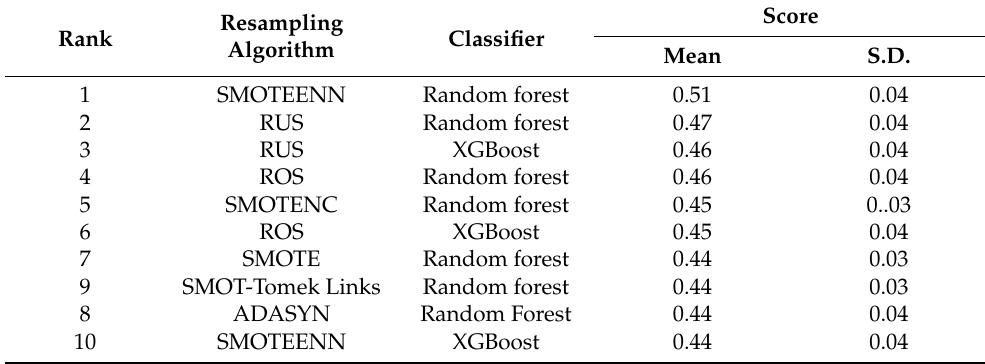
Table 5. Top 10 models ranked according to Score; when the average value of Score was similar, S.D. was